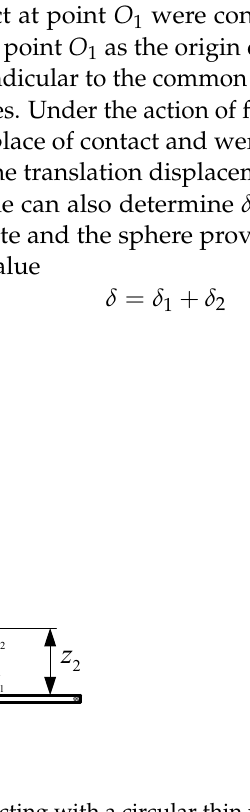
Figure 1. An elastic sphere contacting with a circular thin plate.